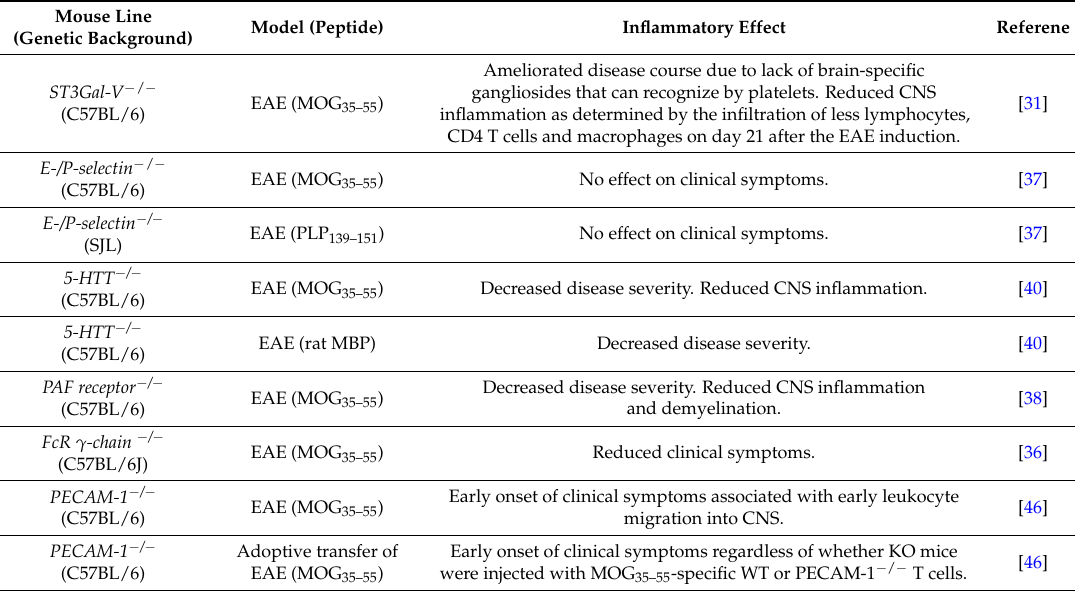
Table 1. Studies of platelets, their receptors and molecules: effects on inflammatory processes of the central nervous system in transgenic